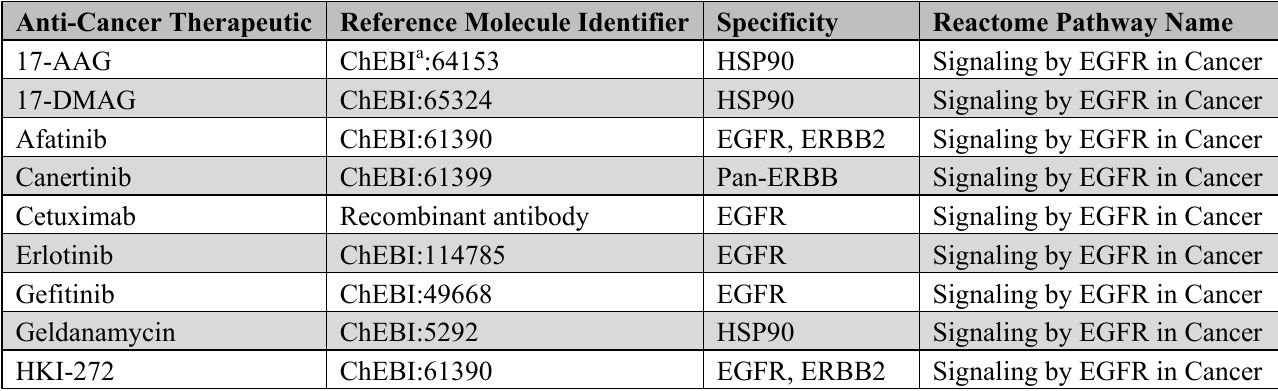
Table 2. Anti-cancer therapeutics published by Reactome to date. A total of 39 small molecule inhibitors and 2 recombinant antibodies have been published since the start of the project in December